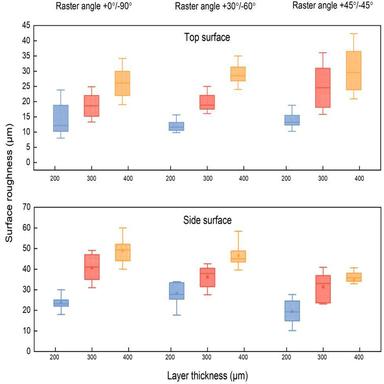
Box plots of the surface roughness of the top (at top) and side surface (at bottom) of sintered zirconia specimens with different layer thicknesses and raster angles.